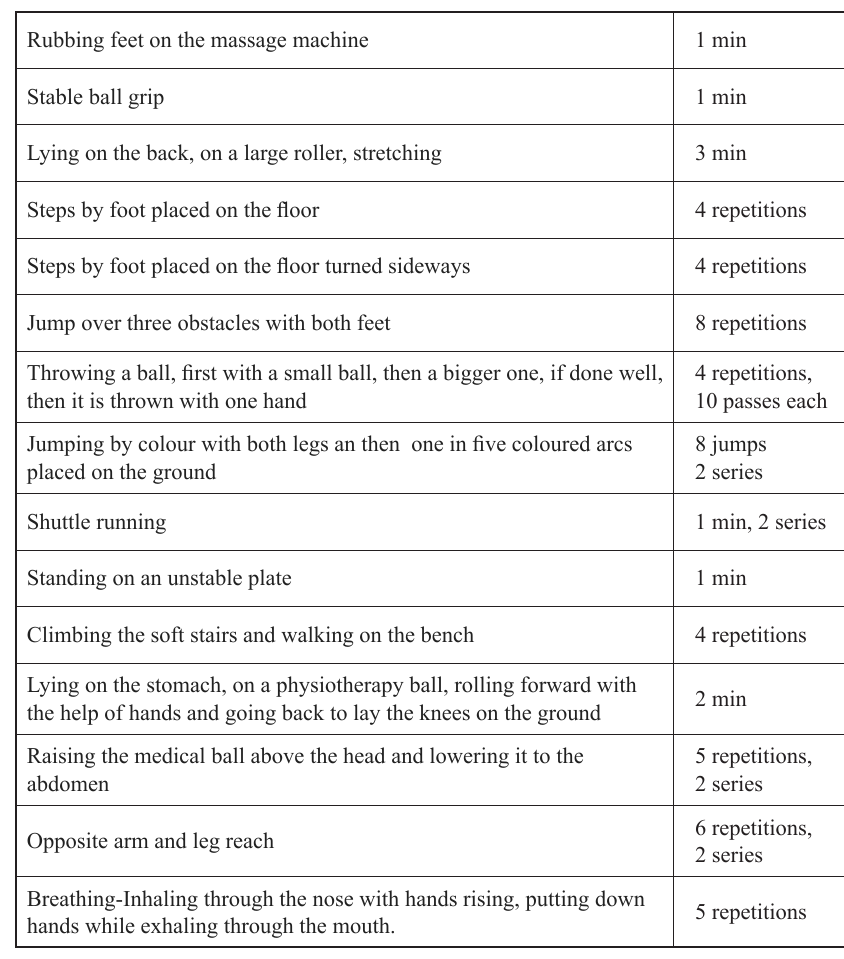
Table 2. The physiotherapy